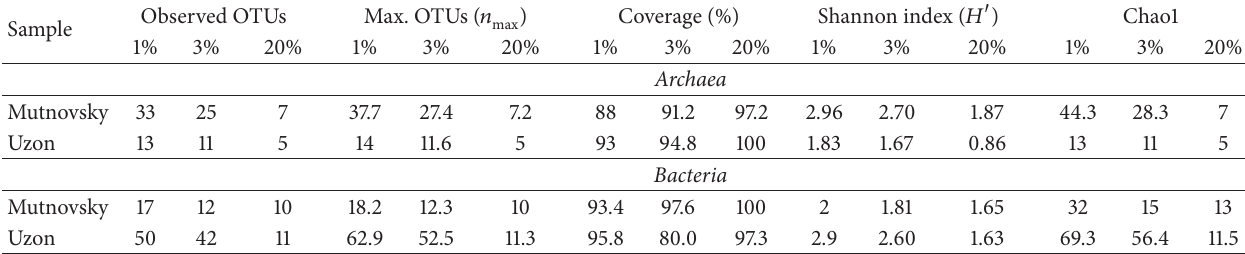
Table 2: Prokaryotic diversity and richness at 1, 3, and 20% genetic distance. Numbers of observed OTUs as well as Shannon and Chao1 indices were calculated with QIIME [16]. The maximal number of OTUs ( 𝑛 max ) was calculated using the Michaelis-Menten-fit diversity metrics implemented in the QIIME package. Coverage was determined by dividing the observed number of OTUs with 𝑛 max .